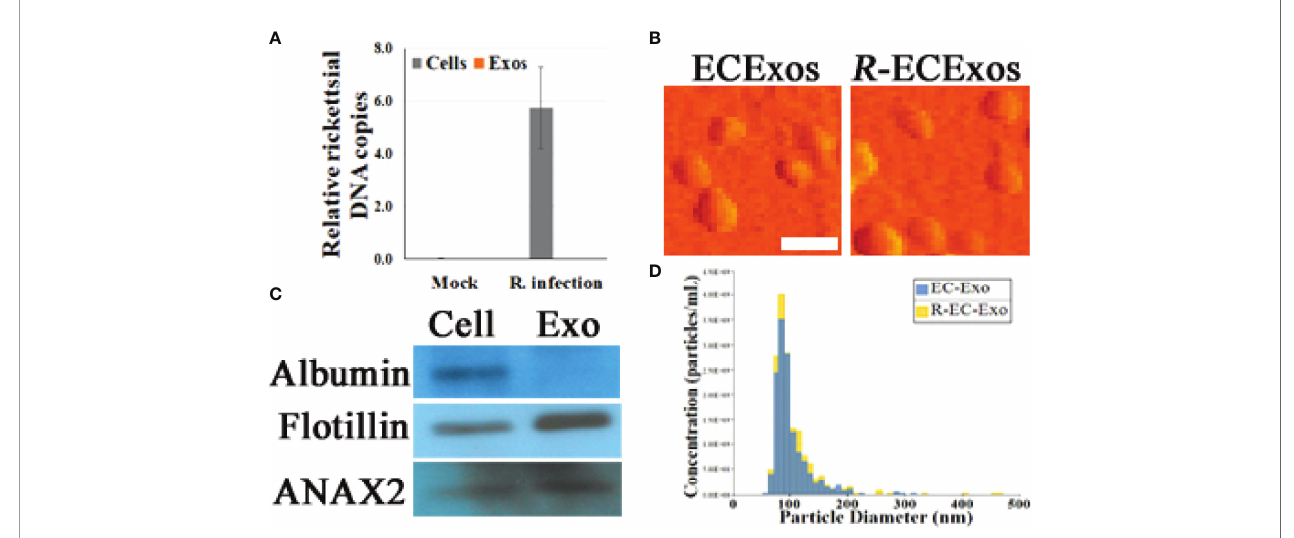
FIGURE 1 | Characterization of HUVEC-derived ECExos using SEC isolation. (A) Quantities of rickettsiae in parent ECs and ECExos ( n =3/group), determined by quantitative real-time PCR. Data are presented as means ± standard errors. (B) ECExo morphology was veri fi ed using AFM de fl ection image (scale bars, 200 nm). (C) Expression of three protein markers in 100 m g protein derived from ECExos was examined using western immunoblotting. (D) , Vesicle size distribution of isolated EVs was analyzed using